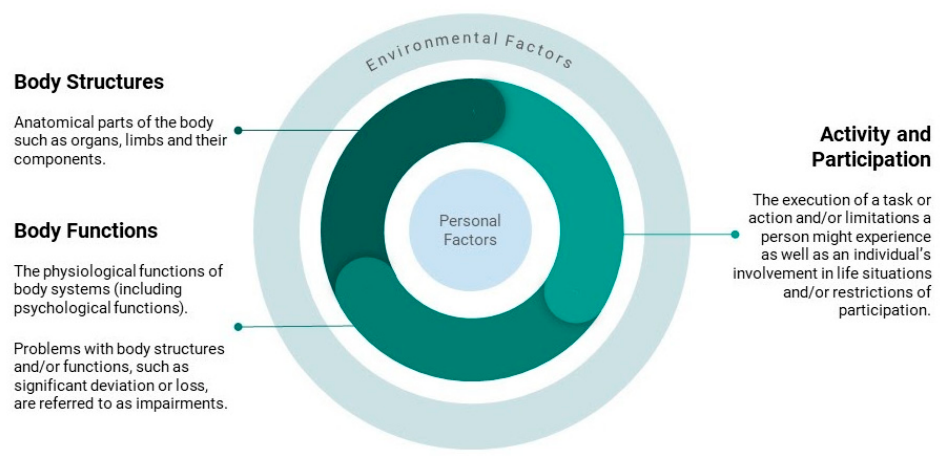
Figure 1. Illustration of the International Classification of Functioning (ICF).